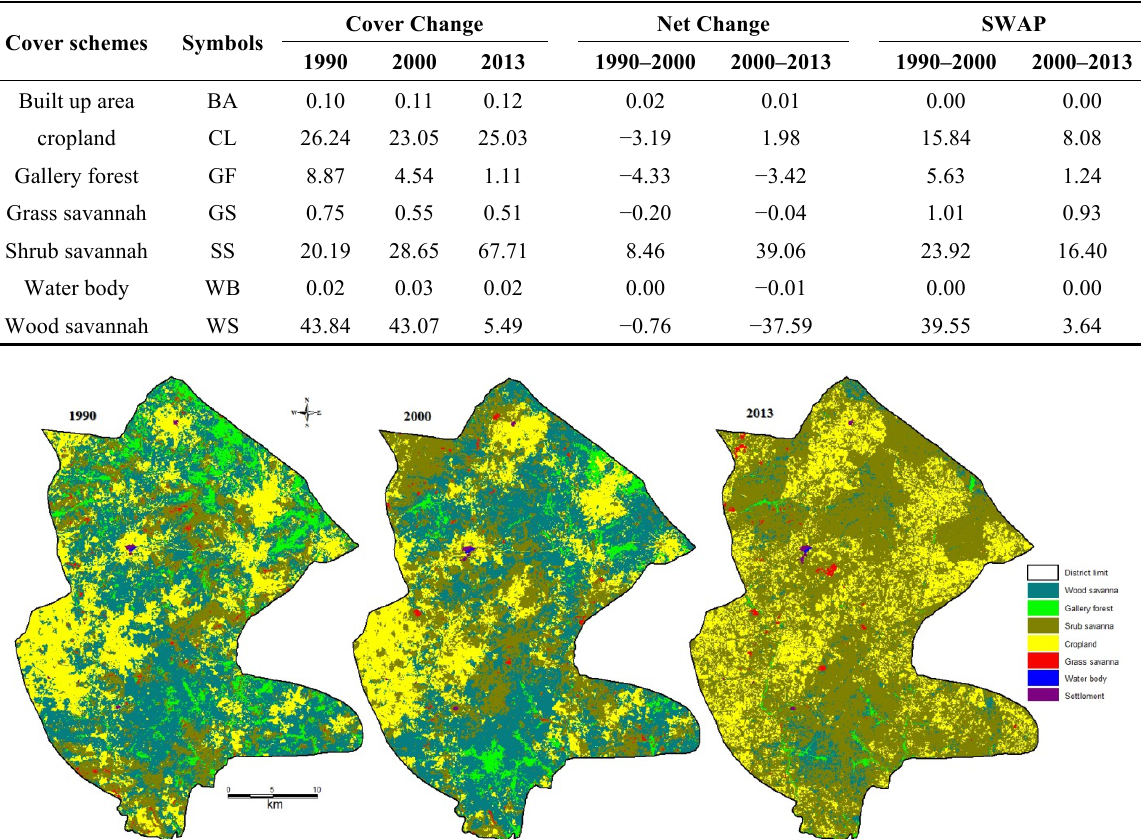
Figure 2. Land cover change in